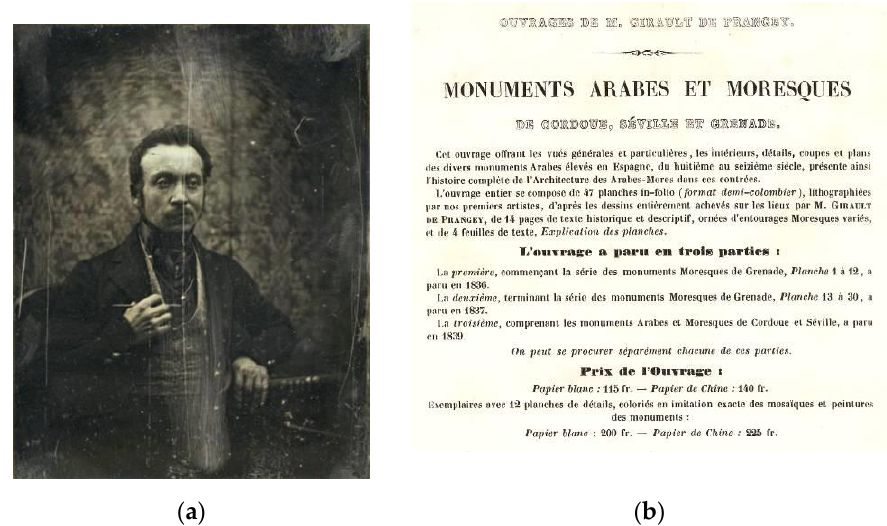
Figure 4. ( a ) Girault de Prangey’s self-portrait (1840). Source: gallica.bnf.fr, Bibliothéque Nationale de France; ( b ) Plate ads from Granada (1836 and 1837), Cordoba and Seville (1839). Source: Private collection.